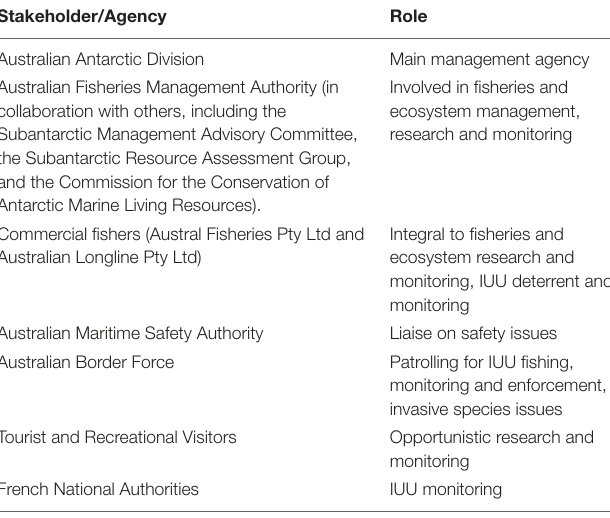
TABLE 1 | Collaborative management of HIMI Marine